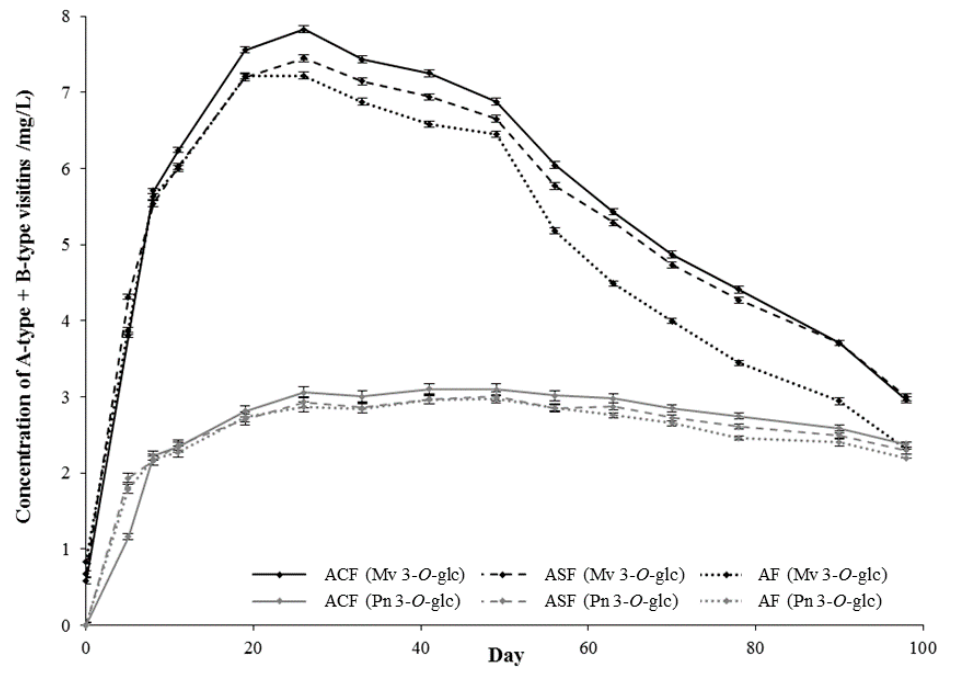
Figure 3. Evolution of the mean concentration ( n = 6) of A-type + B-type vitisins of peonidin 3- O -glucoside (gray lines) and of malvidin 3- O -glucoside (black lines) in the model systems made with the standard medium resulting from the fermentative metabolism of glucose in the absence ( AF ) or presence of enological tannins ( ACF and ASF , added with tannin C or S , respectively).